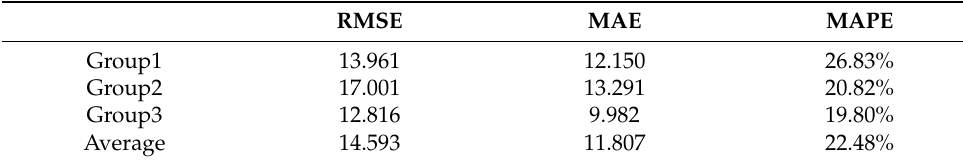
Table 5. GBDT prediction performance under a test